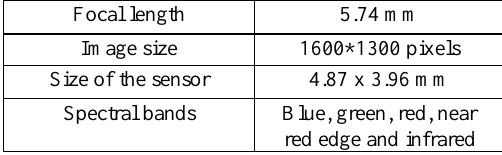
Table 1. Specifications of the DJI PM4 UAV